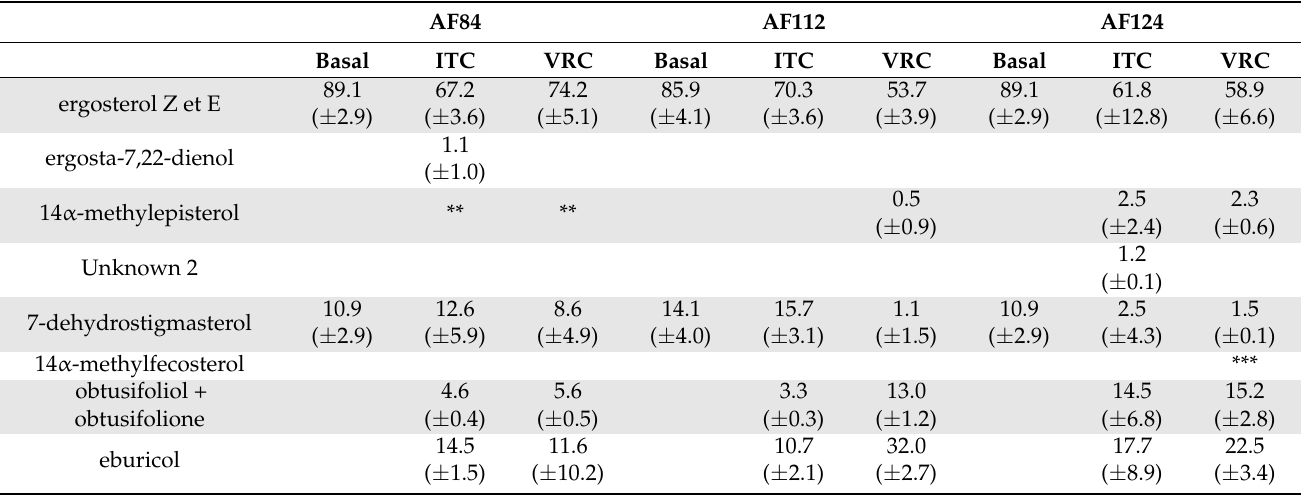
Table 6. Relative composition of sterols of group 4, strains with TR 53 alterations, under basal conditions or after in vitro exposure to itraconazole (ITC) (concentration = 32 mg/L except